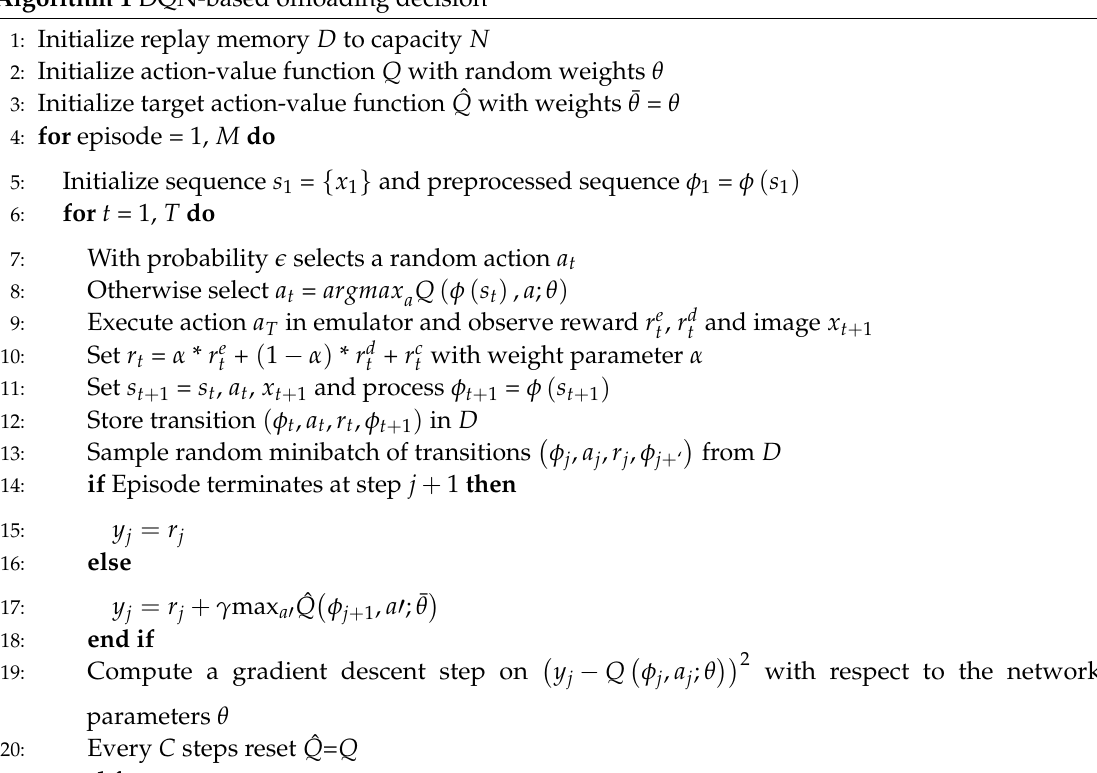
Algorithm 1 DQN-based offloading